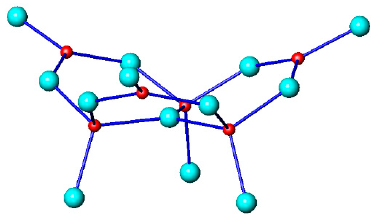
3 B 6 O 10 Br ( a ) and its inversion twin ( b ).